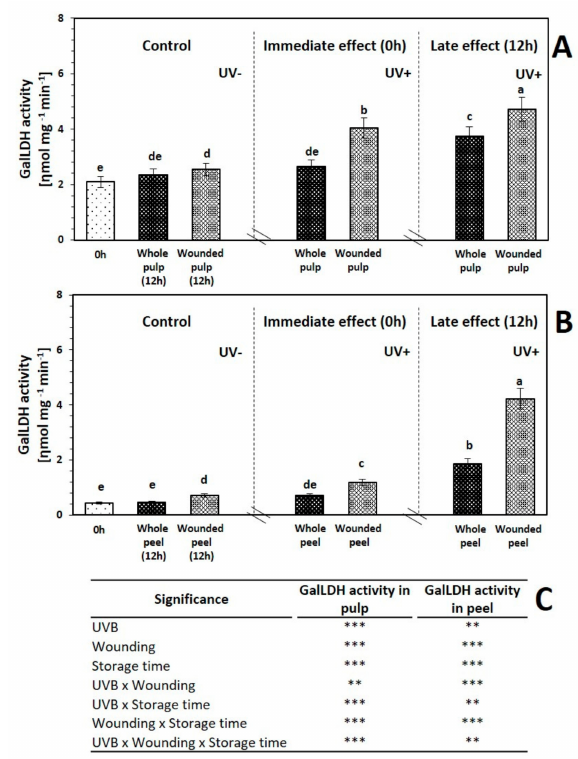
Figure 4. Enzymatic activit y of l -galactono- γ -lactone dehydrogenase (GalLDH) before and after storage (12 h at 16 ◦ C) of whole and wounded red prickly pear ( A ) pulp and ( B ) peel treated with UVB light (6.4 W · m − 2 ) for 0 and 15 min. ( C ) Full factorial analyses of variance showing the main e ff ects and interactions of the variables evaluated. Bars are means of three replicates ± standard error. Di ff erent letters among bars indicate statistical di ff erence between treatments using the least significant di ff erence (LSD) test ( p < 0.05). Asterisks indicate that main e ff ects and interactions are significantly di ff erent by analyses of variance (ANOVA). NS—non significant, * p < 0.05, ** p < 0.01, *** p < 0.001. Results are expressed as oxidized η mol L-Gal per mg of protein per